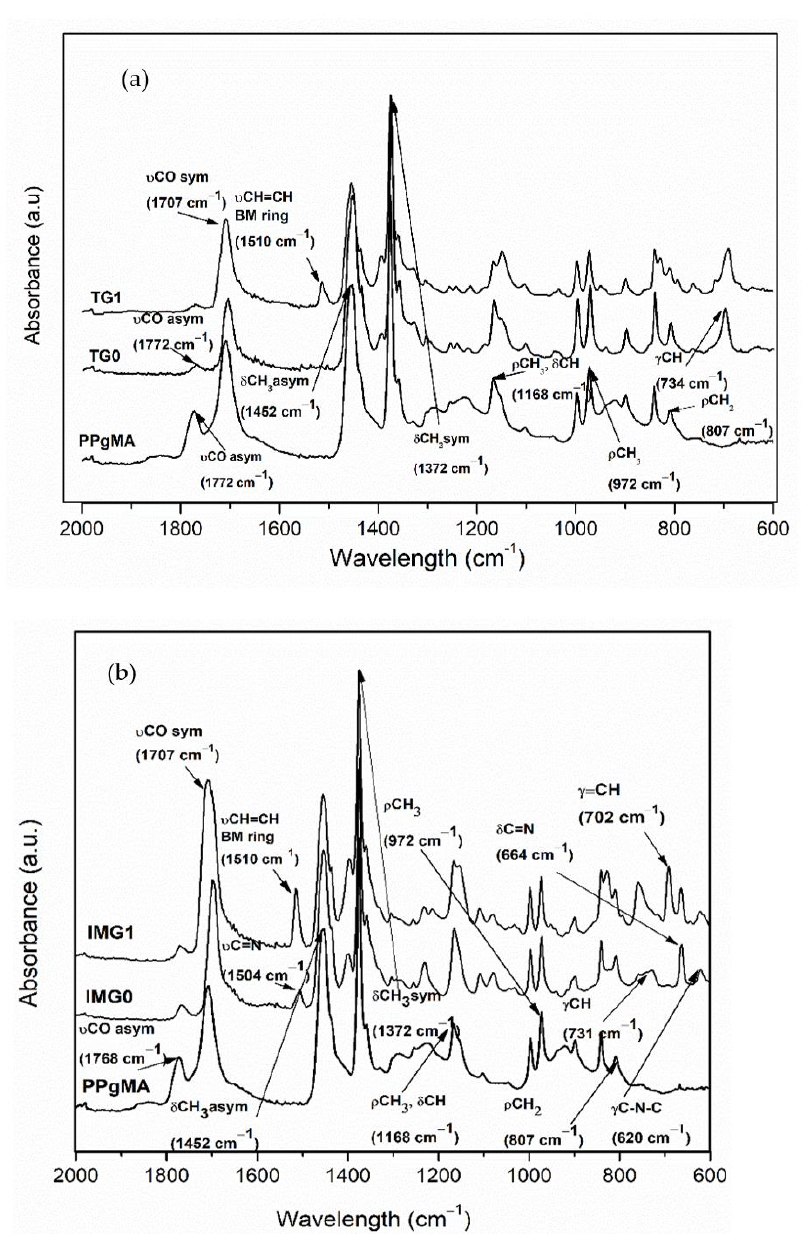
Figure 2. FTIR spectra of maleated PP and its derivatives with thiophene ( a ) and imidazole ( b ) in the absorption range of 600 − 2000 cm − 1 .